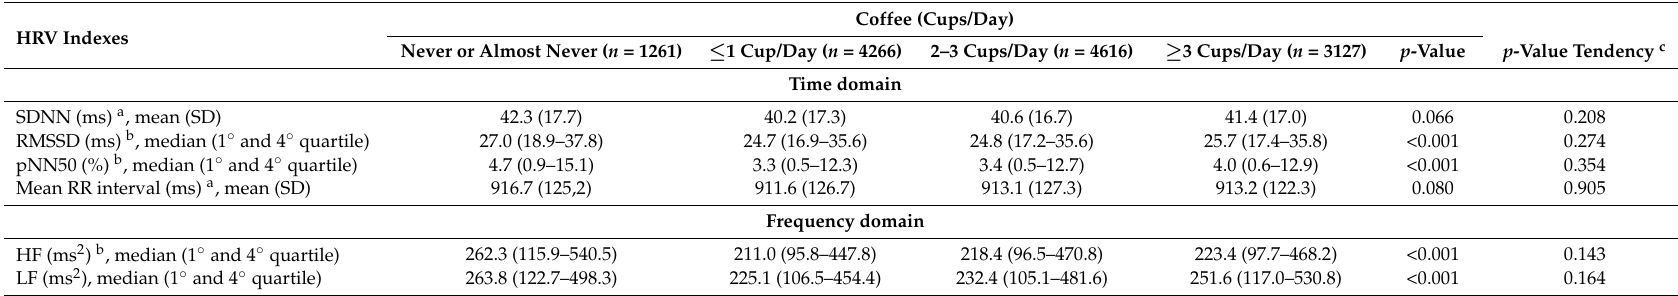
Table 2. Mean (standard deviation) and median (interquartile range) of heart rate variability (HRV) indexes for by coffee consumption frequency in the last 12 months in ELSA-Brasil participants